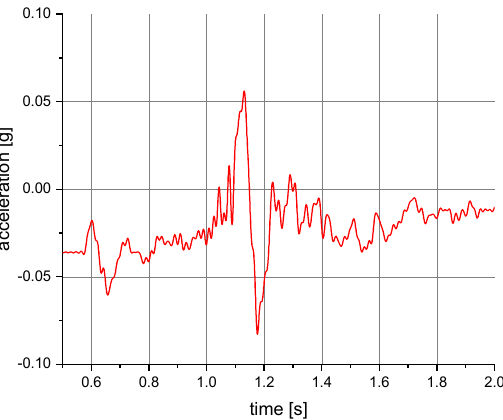
Figure 8. Acceleration as a function of time recorded during tipping. Test conditions: self-locking device at a level of 1.5 m above floor level; front point of the safety harness; the sensor mounted on the abdomen of the manikin.